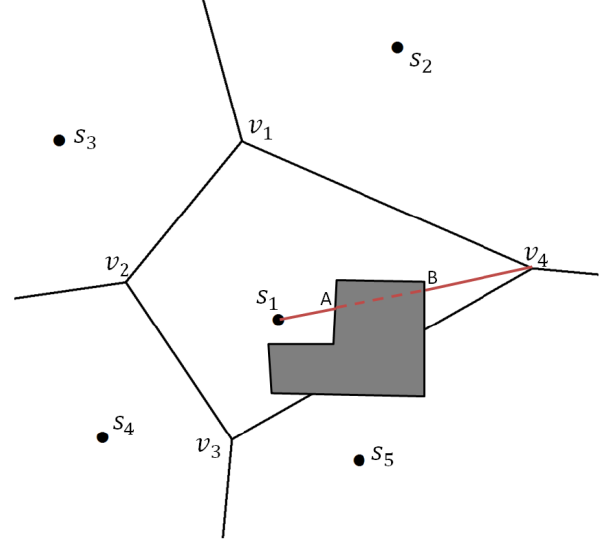
Figure 13. Sensor’s move representation in case of considering the restricted area. Searching locations have been limited to lines s 1 A and B v 4 .